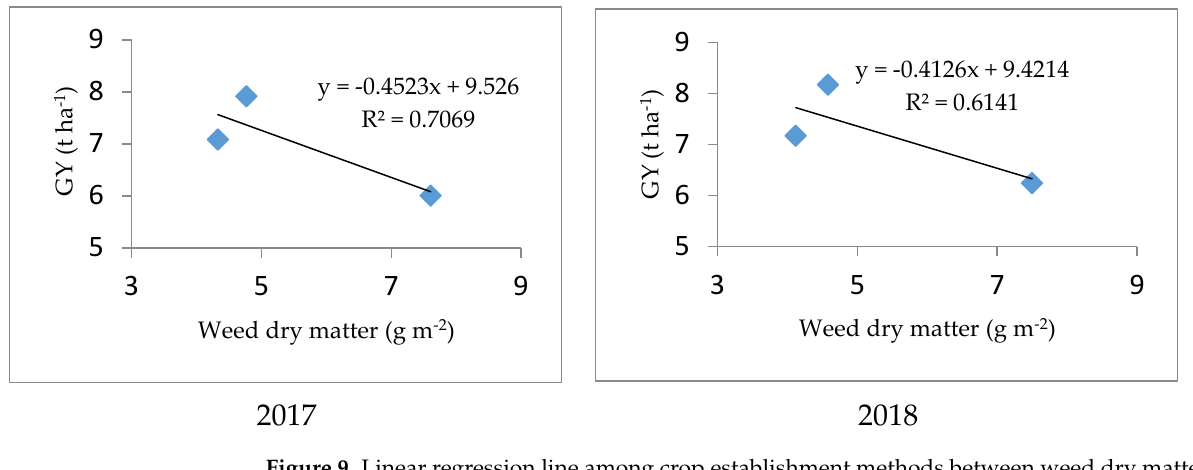
Figure 9. Linear regression line among crop establishment methods between weed dry matters vs. Grain yield (GY).